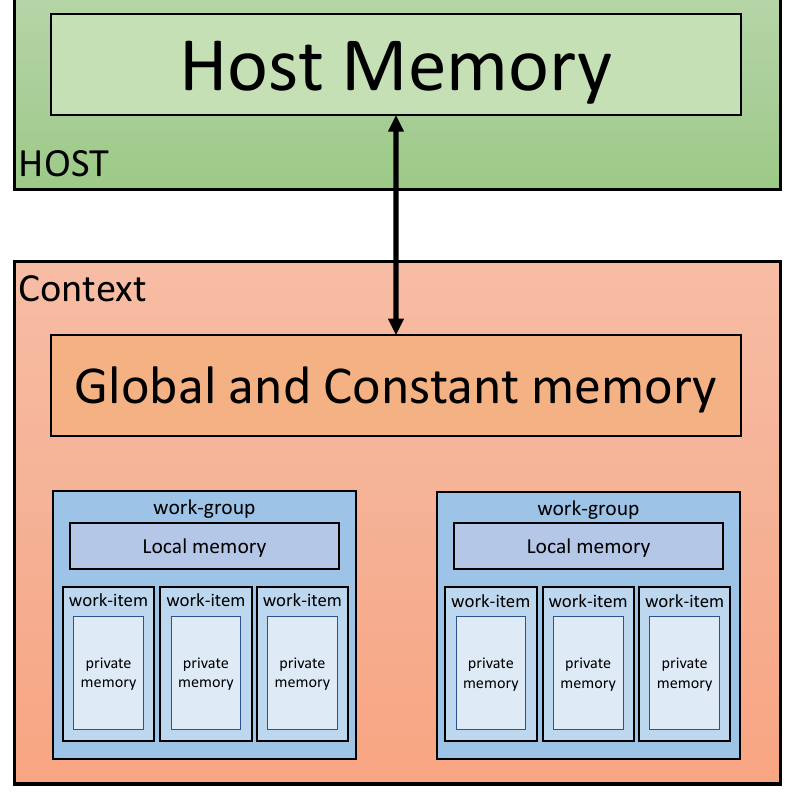
Figure 4. OpenCL memory structure [13].